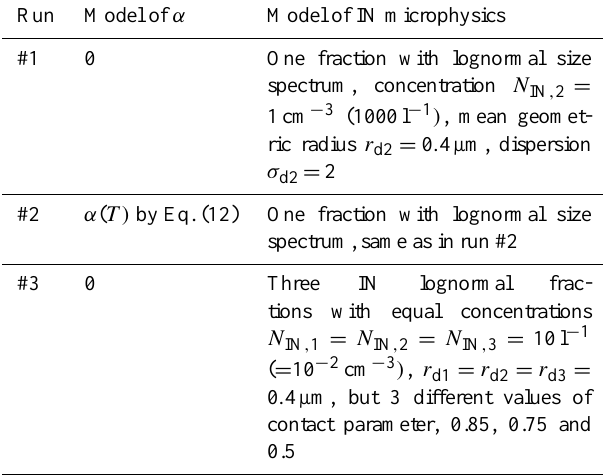
Table 1. Parameters of the 3 simulations (runs) of the parcel model with the KC scheme and various input